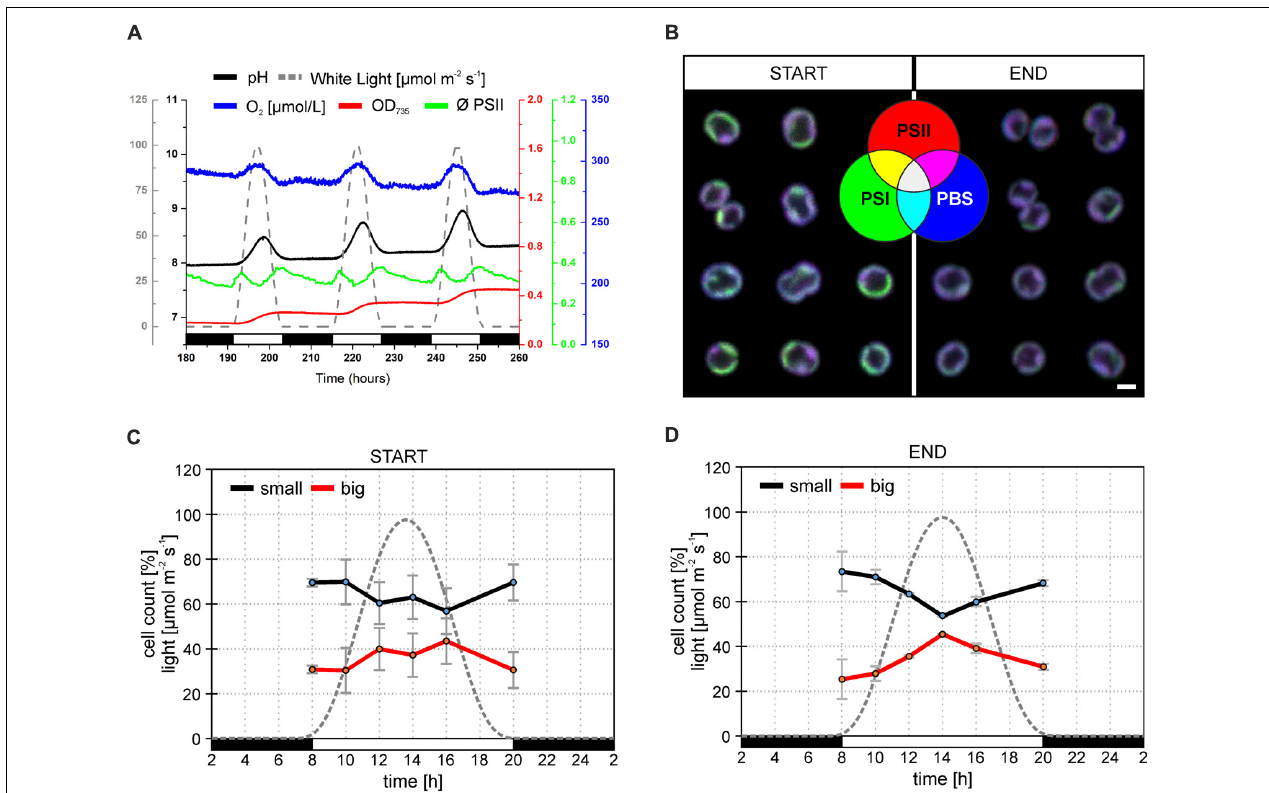
FIGURE 1 | Behavior of Synechocystis PSI-YFP cells during cultivation in the bioreactor. The original starting culture (“START”; cells acclimated to continuous light; days 2 and 3 in the bioreactor) was slowly acclimated to the sinusoidal light-dark cycle (12/12 h marked by white/black bars, maximal intensity 100 µ mol m - 2 s - 1 ). The light intensity profile is depicted as a gray dotted line. Cells grew in the bioreactor for 2 weeks to be considered as acclimated to the light-dark cycle (“END”; days 13 and 14 in the bioreactor). (A) Dynamic behavior of Synechocystis PSI-YFP cells during cultivation in the bioreactor in situ. Parameters represent: (1) OD 735 optical density (red line) measured at 735 nm representing growth of biomass; (2) pH of culture (black line); (3) O 2 dissolved in water (blue line); (4) φ PSII (green line) representing actual PSII efficiency under red light; (5) light intensity ( µ mol m - 2 s - 1 ; gray dashed line). Data represent typical behavior of the parameters for days 6, 7, and 8 of bioreactor experiment. (B) Confocal microscope images of Synechocystis PSI-YFP cells at the start (days 2 and 3) and at the end (days 13 and 14) of bioreactor experiment. Three channel RGB pictures represent three acquired fluorescence signals showing localization of three complexes: (1) red—PSII autofluorescence; (2) blue—PBS autofluorescence; (3) green—PSI-YFP fluorescence. A combination of these three signals provides four additional membrane areas reflecting the co-localization of PSI/PSII/PBS. Overlapping signals create: (4) magenta—dominant PSI and PSII (low PBS); (5) cyan—dominant PSI and PBS (low PSII); (6) yellow—dominant PSI and PSII (low PBS); (7) white—PSI, PSII, and PBS are in similar, high content. Pictures represent typical thylakoid membrane organization of Synechocystis PSI-YFP during bioreactor experiment. Total number of analyzed cells per day was between n = 709 and 1565. (C,D) Confocal microscope measurements of cell sizes during the diel cycle, based on acquired images, two cell categories were counted: small (black line, cell area 2.0–2.8 µ m 2 ); big (red line, cell area 2.8–4.0 µ m 2 ). Data represent averages and SD at the start ( C ; days 2 and 3) and at the end ( D ; days 13 and 14) of the bioreactor experiment. Data represent averages of two different days of the bioreactor